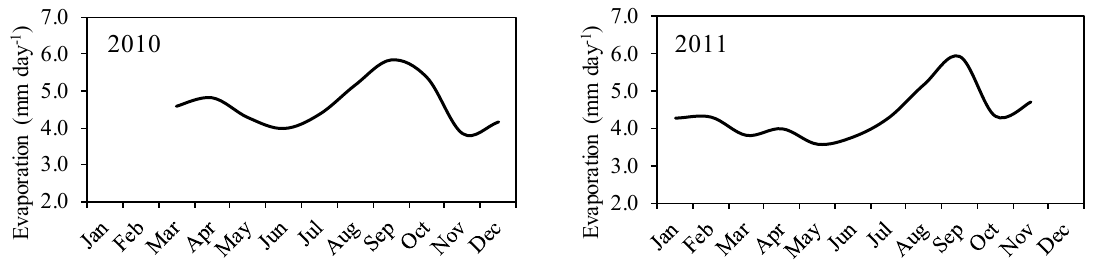
Figure 4. Class A pan evaporation observed for the period from 2010 to 2011.